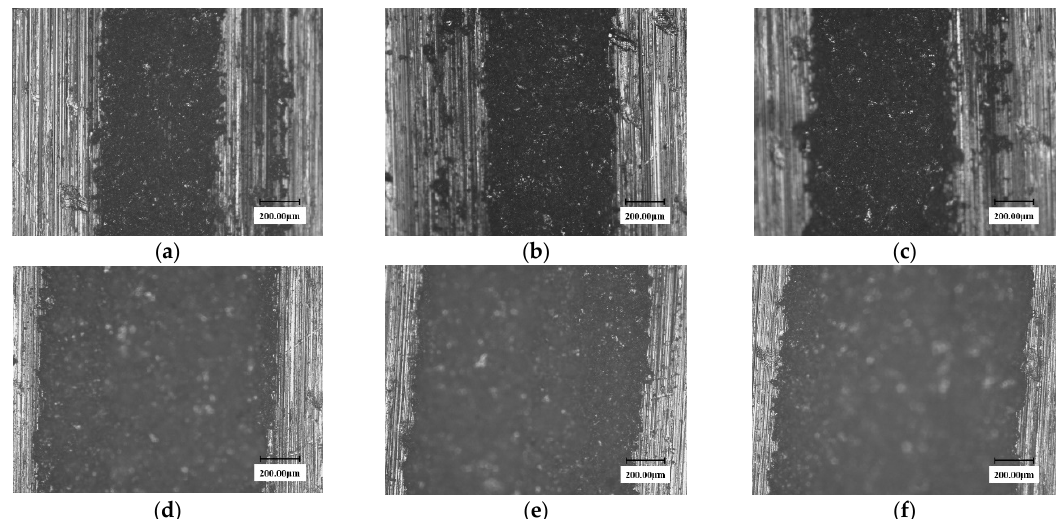
Figure 3. The microscopic morphology of the 90° substrate samples at different testing times in the erosion zone. (nozzle diameter: 0.2 mm). ( a ) 60 min; ( b ) 120 min; ( c ) 150 min; ( d ) 270 min; ( e ) 330 min; ( f ) 390 min.